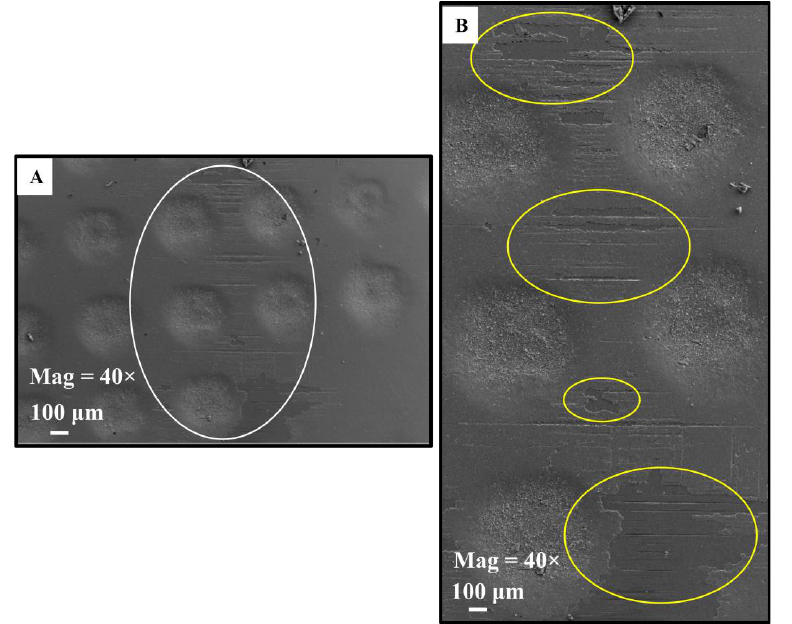
Figure 10. SEM image of the ECP_S C _MoSeC specimen showing: ( A ) Textured surface; ( B ) Magnified image of the scratches.